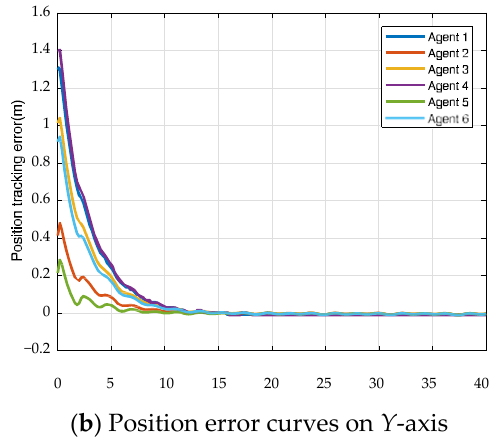
Figure 2. Position error curves of six agents.